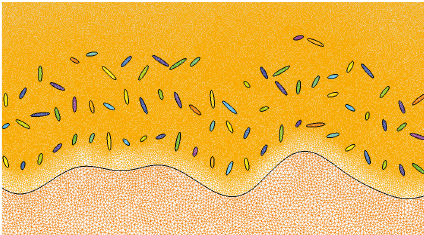
Figure 1: Schematic representations of geometric model for ground surface covered with multilayers vegetation. The typical leaves are modelled with discrete elliptical